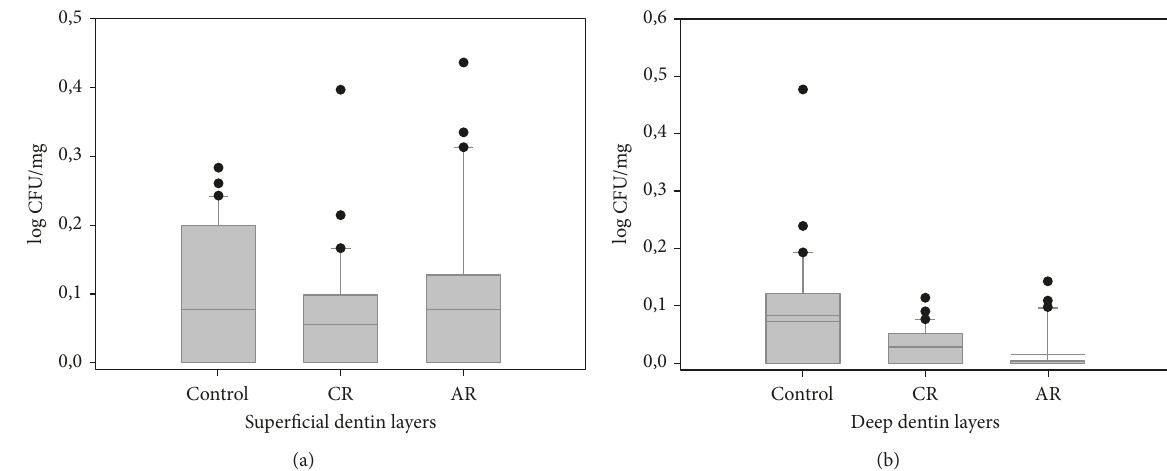
Figure 4: Box plot of E. faecalis amount (logCFU / mg) in the superficial (a) and deep (b) dentin layers.